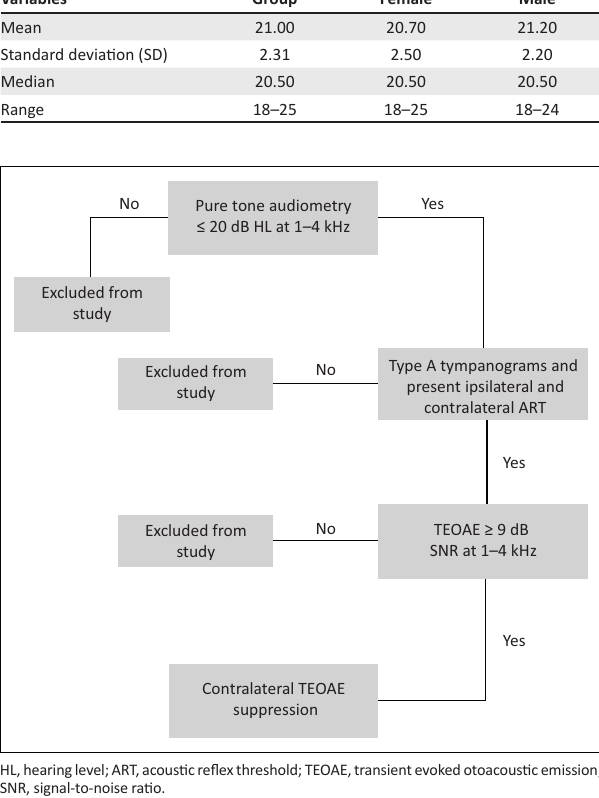
FIGURE 1: Protocol for testing whether subjects met the selection